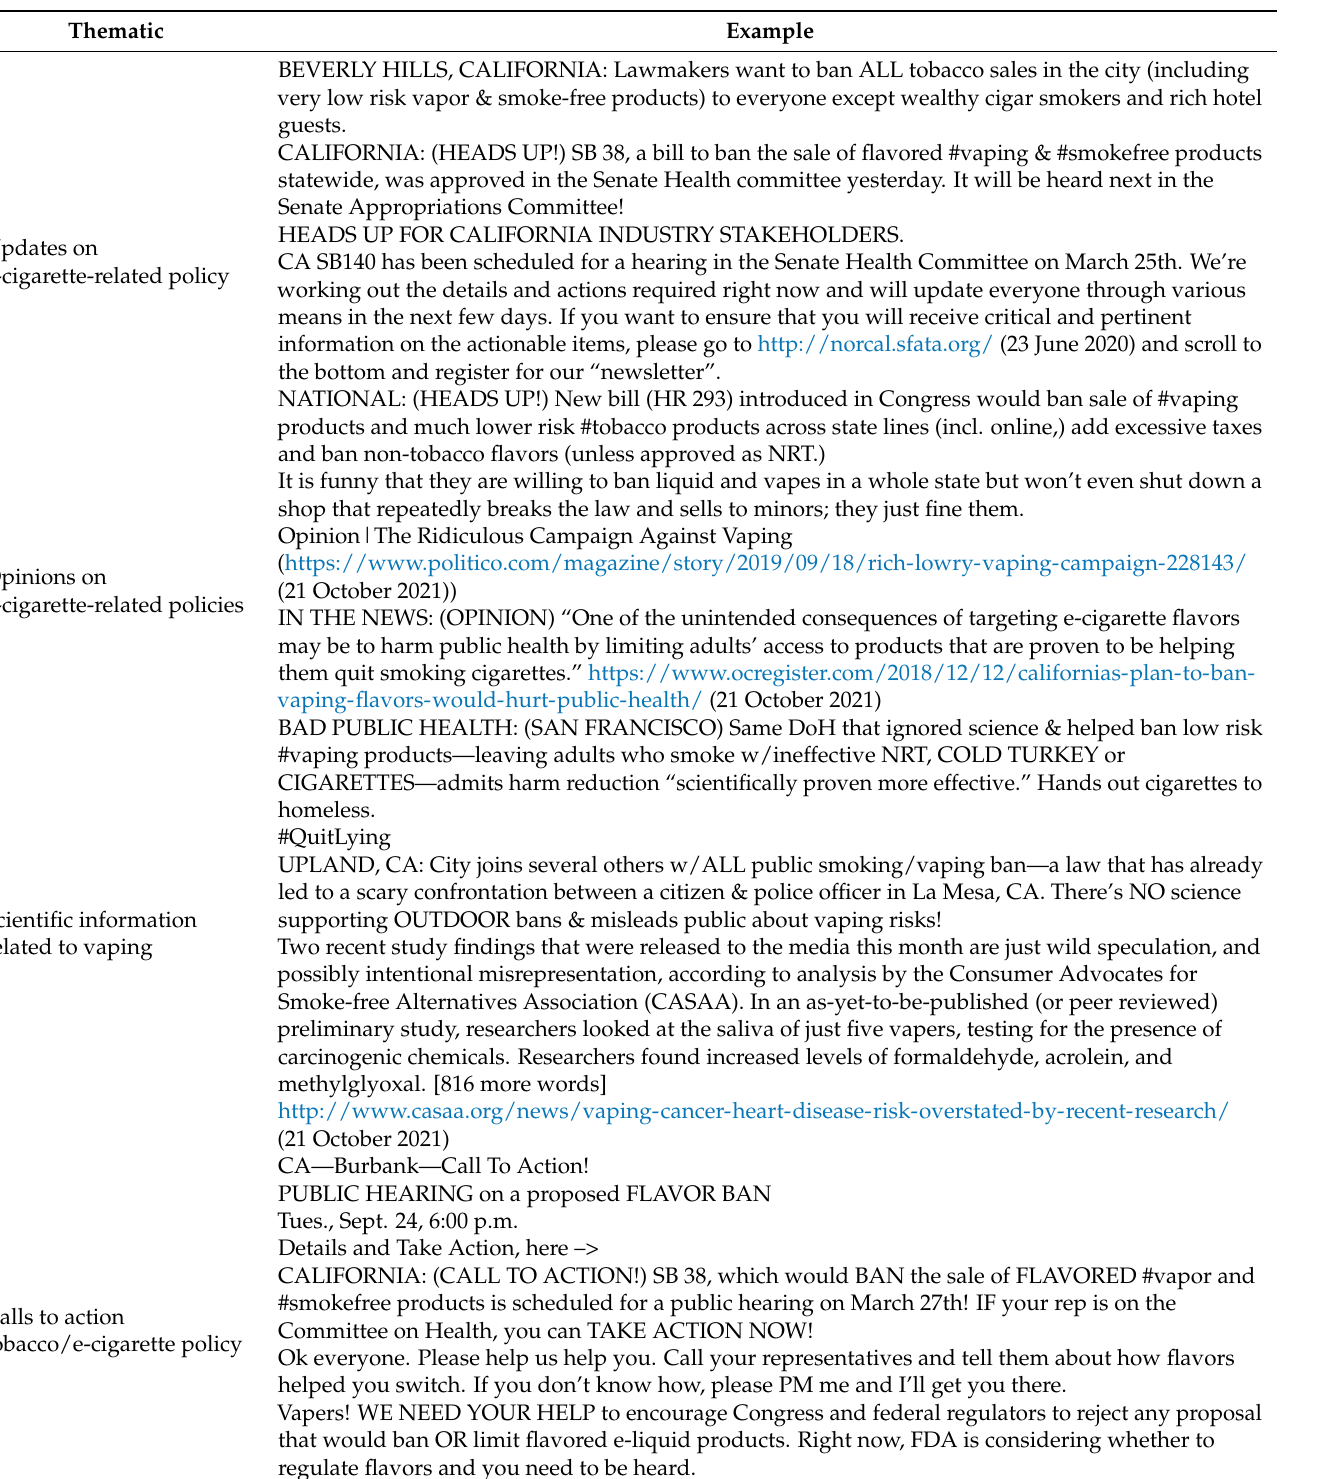
Table 2. Major thematic areas of political interference in Facebook